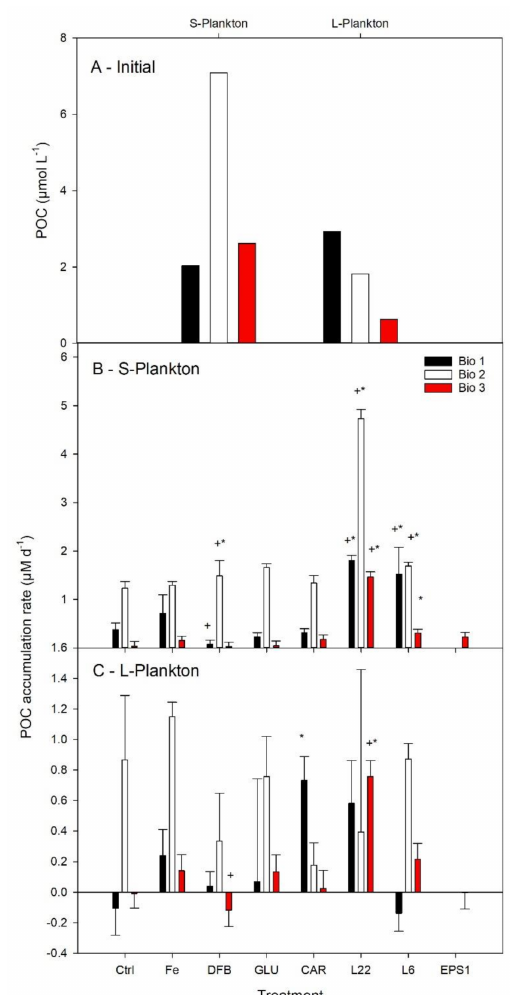
Figure 3. Average particulate organic carbon (POC) concentrations determined for three natural communities of the Drake Passage and the Western Antarctica Peninsula ( A ). Net daily POC accumulationratesfollowingsixdaysofincubationinseawaterenrichedwithiron(Fe)boundtodi ff erent organicligandsisshownforsmall(0.7–10 µ m, S—Plankton, B )andlargeplankton( > 10 µ m, L—Plankton, C ). The treatments presented are: Ctrl (control, no Fe enrichment), Fe (inorganic Fe addition, FeCl 3 ), DFB (desferrioxamine B), GLU (glucuronic acid), CAR (carrageenan), L 6 (bacterial exopolymeric substance (EPS)), L 22 (bacterial EPS), and EPS1 (in situ EPS isolated from Bio 1). Error bars indicate standard deviation ( n = 4). Statistical di ff erences (level 0.05) with the Ctrl and the Fe treatments are shown by an asterisc (*) and a plus ( + ) symbol,